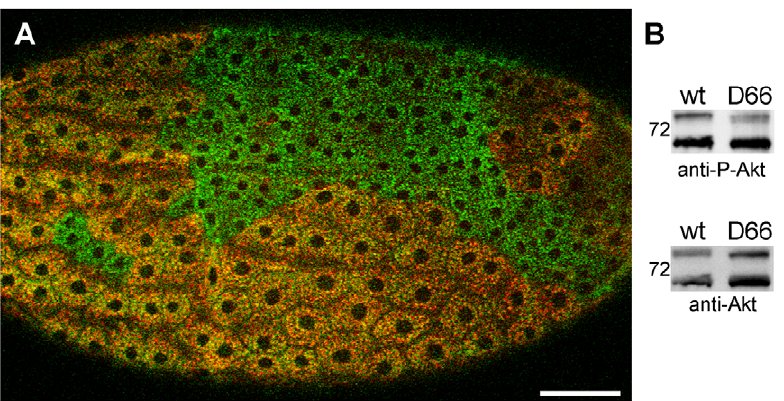
Figure 5. Liquid facets-Related mutants display a cell growth phenotype. (A) Follicle cells of an early stage 14 egg chamber stained with anti-p120 (green) and anti-LqfR (red) showing two lqfR D66 clones. Image is a confocal z-stack projection. Anterior is to the left, dorsal is up. Bar, 50 m m. (B) Western blot of lysates from wild type and lqfR D66 adult females. The blot was first probed with anti-phospho-Akt (top), then stripped and reprobed with anti-Akt (bottom). Similar results were obtained when blots were probed first with anit-Akt and then anti-phospho-Akt1 (data not shown). M r of the 72 kDa protein marker is shown.